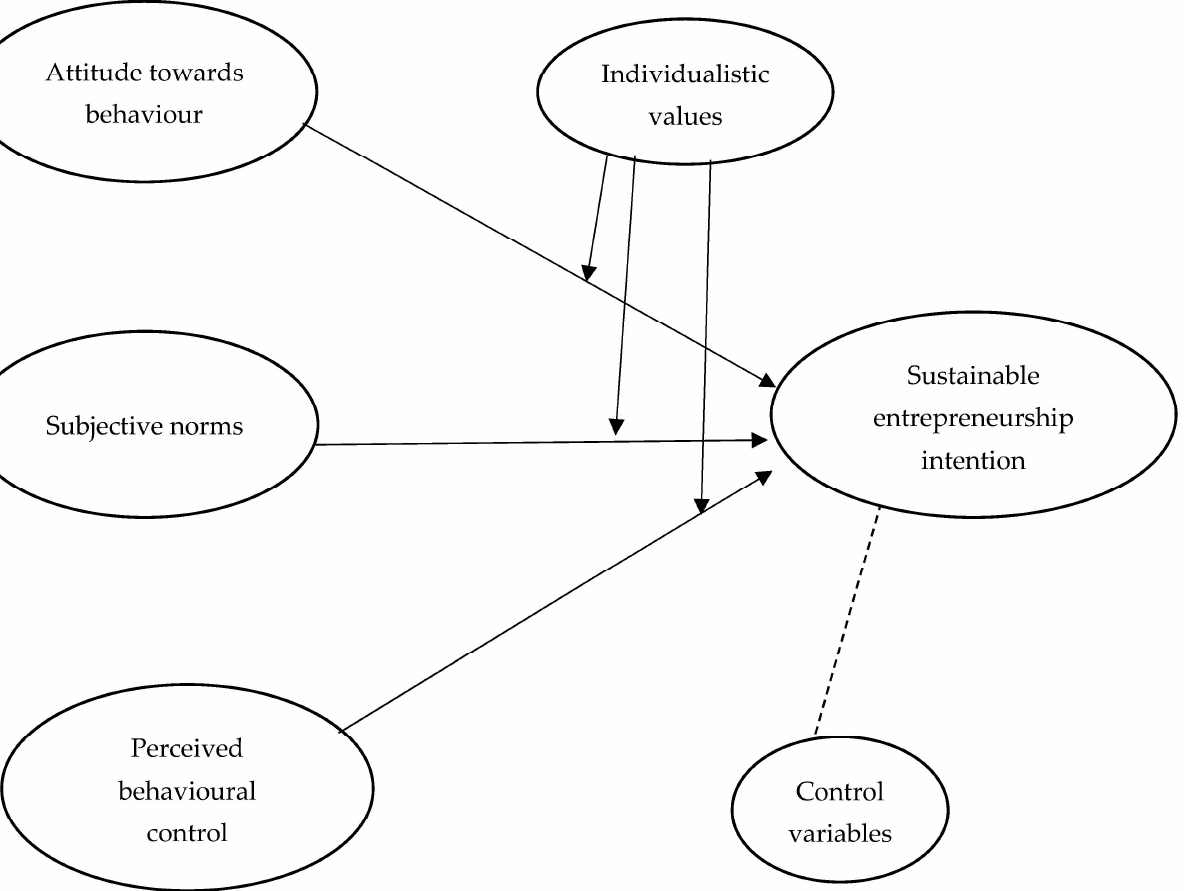
Figure 1. Diagrammatic representation of hypothesised relationships.